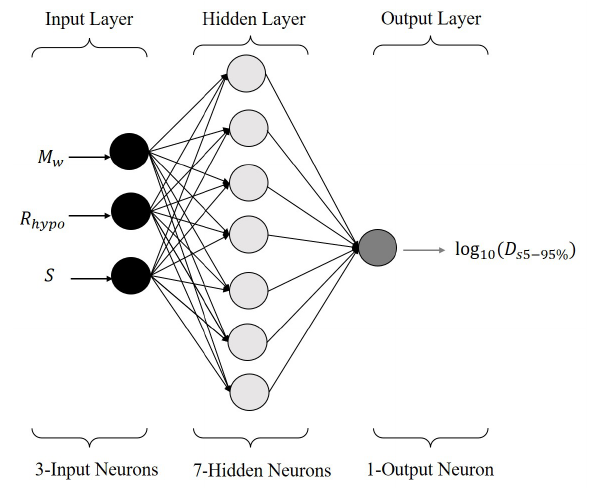
Fig. 5. Architecture of ANN model used in this